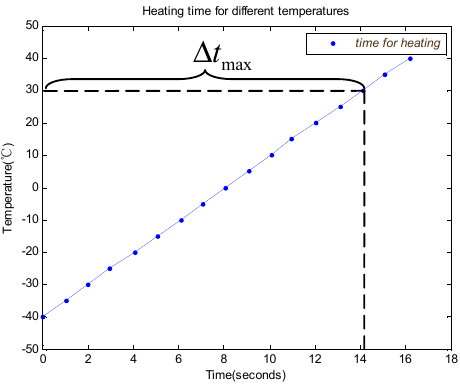
Figure 12. The heating time for different ambient temperatures.